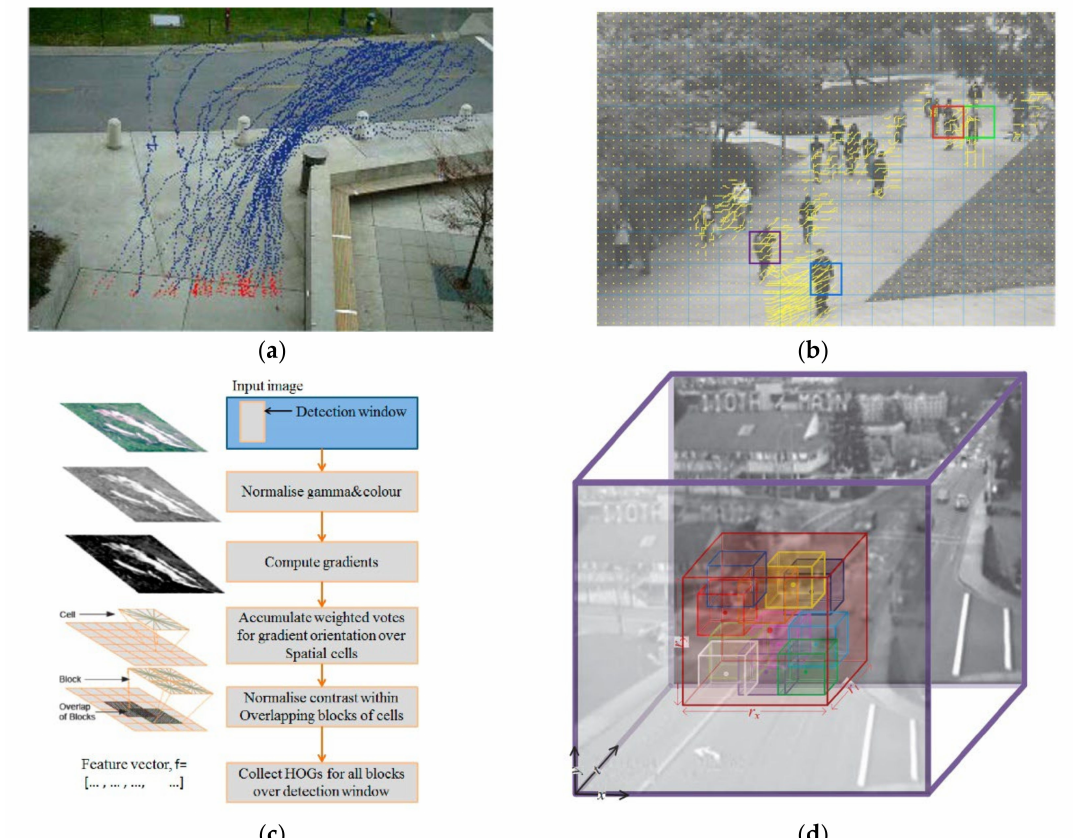
Figure 1. Examples of the hand-crafted feature. ( a ) Object trajectory [24]. ( b ) Dense trajectory [26]. ( c ) Histograms of gradients (HOG) [31]. ( d ) Spatio-temporal video volumes (STVs)